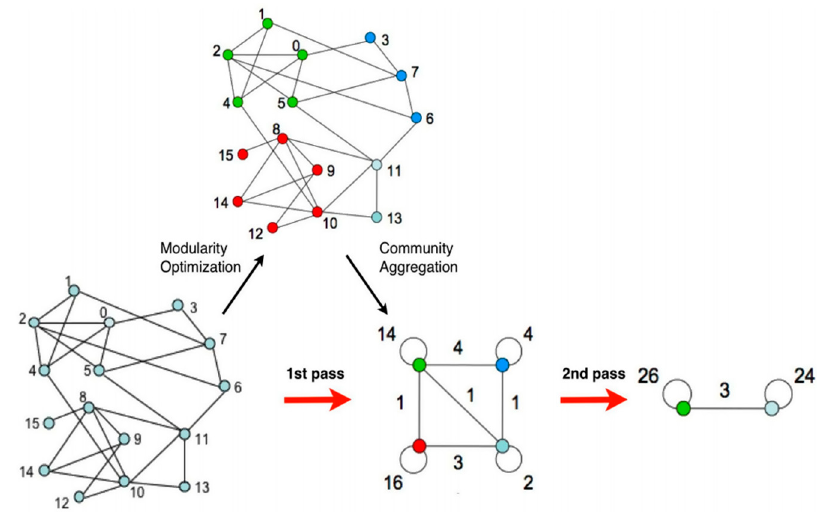
Figure 1. Modularity Report algorithm explanation. Source: adapted from Blondel et al. [46].